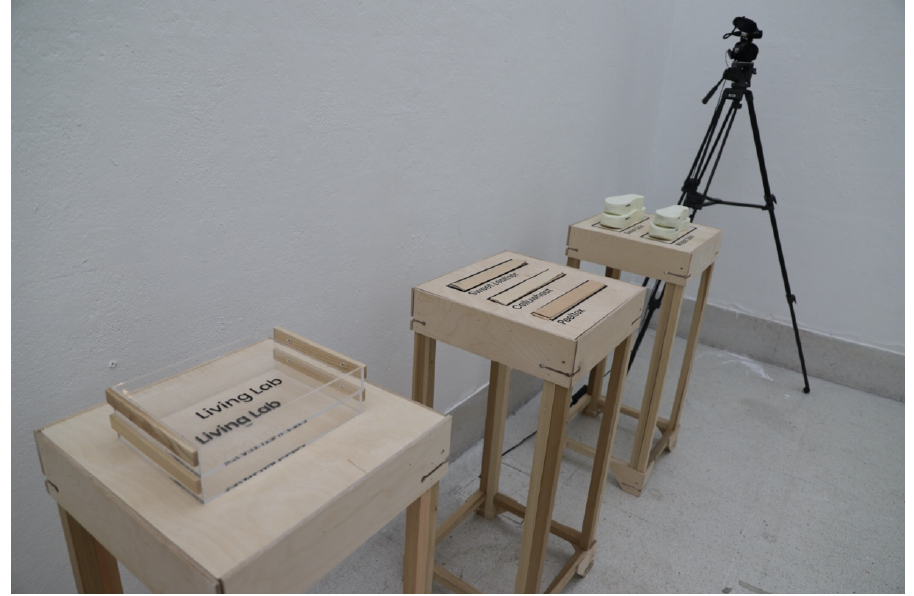
Figure 4. Selection of components.